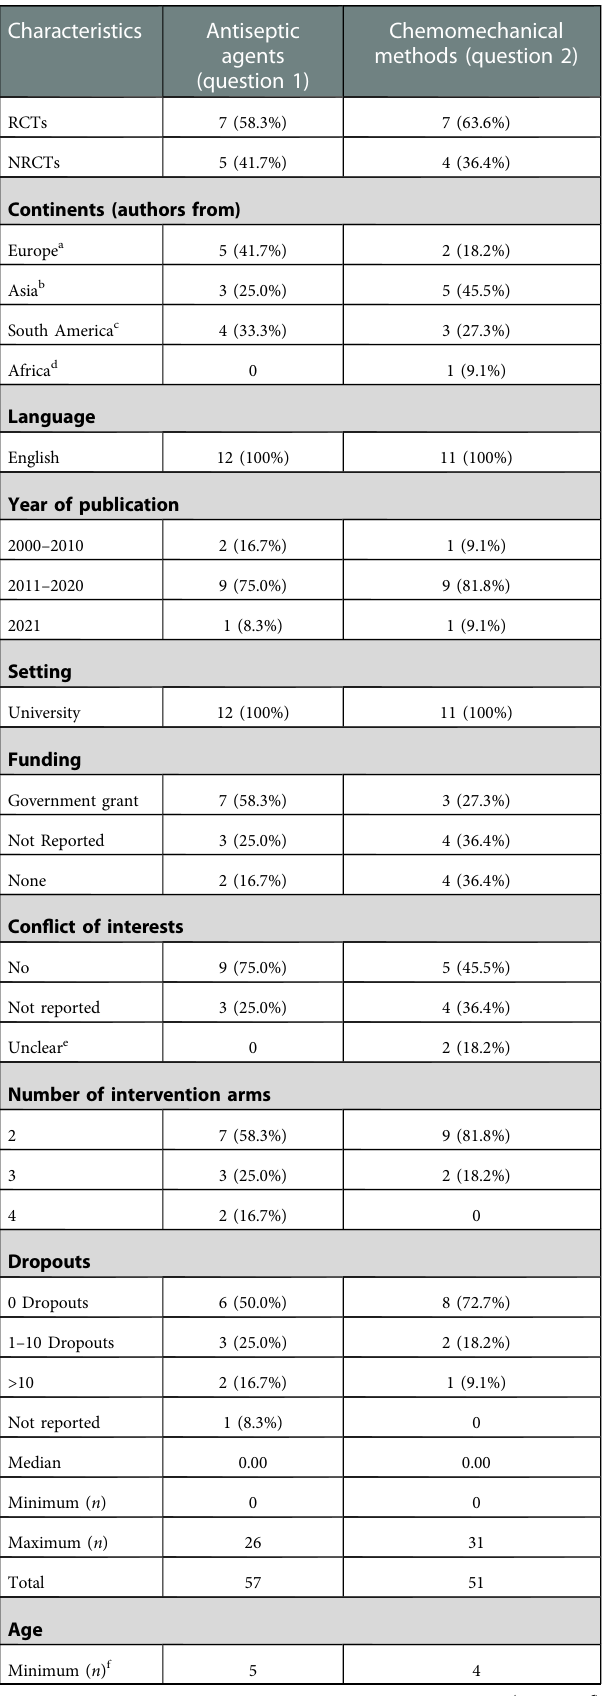
TABLE 1 Summary of study